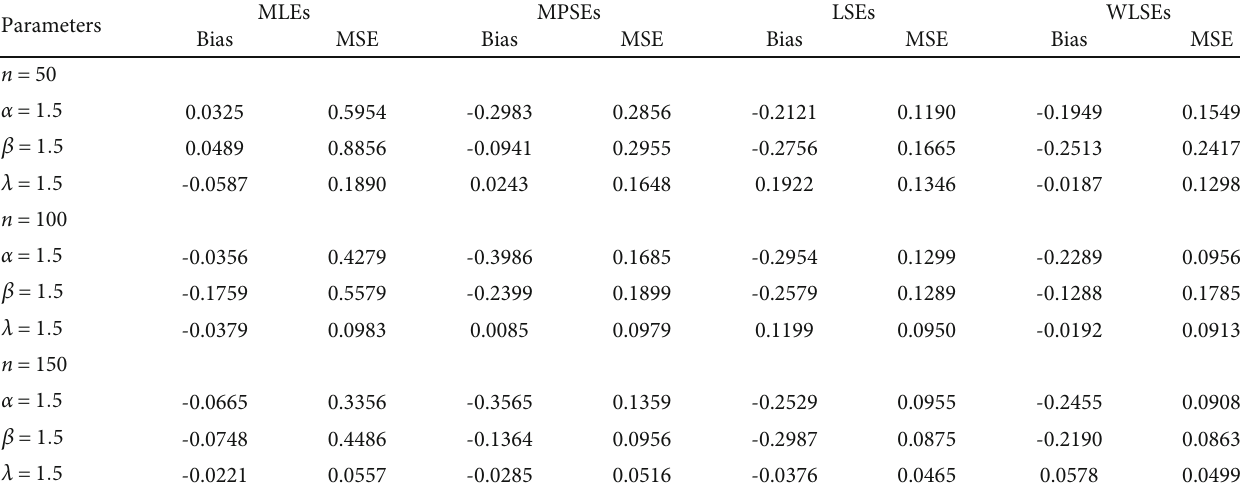
Table 5: Bias and MSE values for α , β , and λ of the XGAIW distribution.